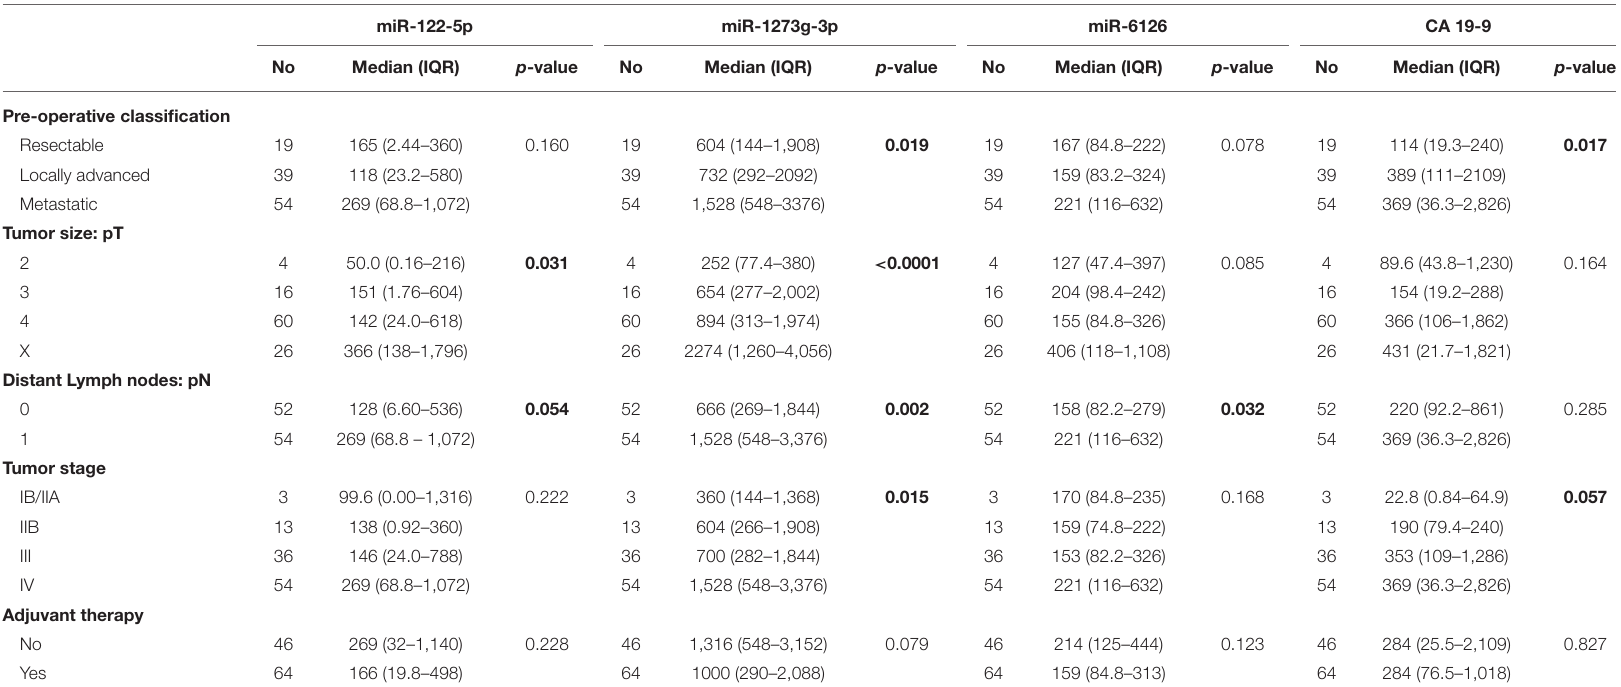
TABLE 4 | Associations of clinical-pathological features associated with oncogenic miRNAs and CA 19-9 levels in patients with pancreatic